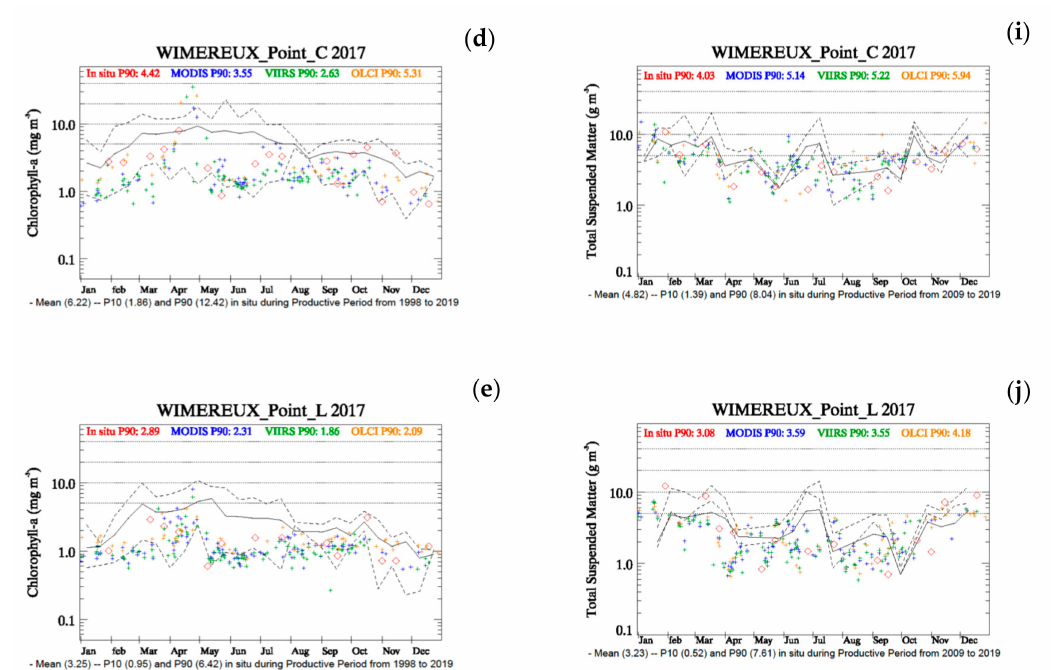
Figure 4. Chl- a ( a – e ) and TSM ( f – j ) in the eastern English Channel. In situ and satellite percentiles of year 2017 are indicated in the upper part of the graphs; the in situ historical mean, P10 and P90, calculated over the productive period, are indicated under the time axis.